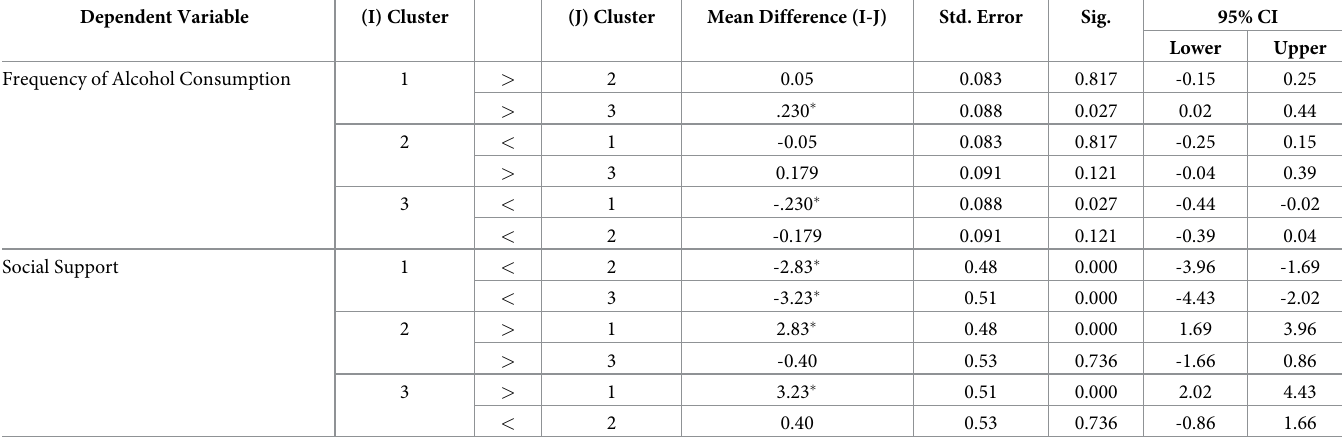
Table 5. Multiple comparisons (Tukey HSD). Factor: Two Step Cluster (Model